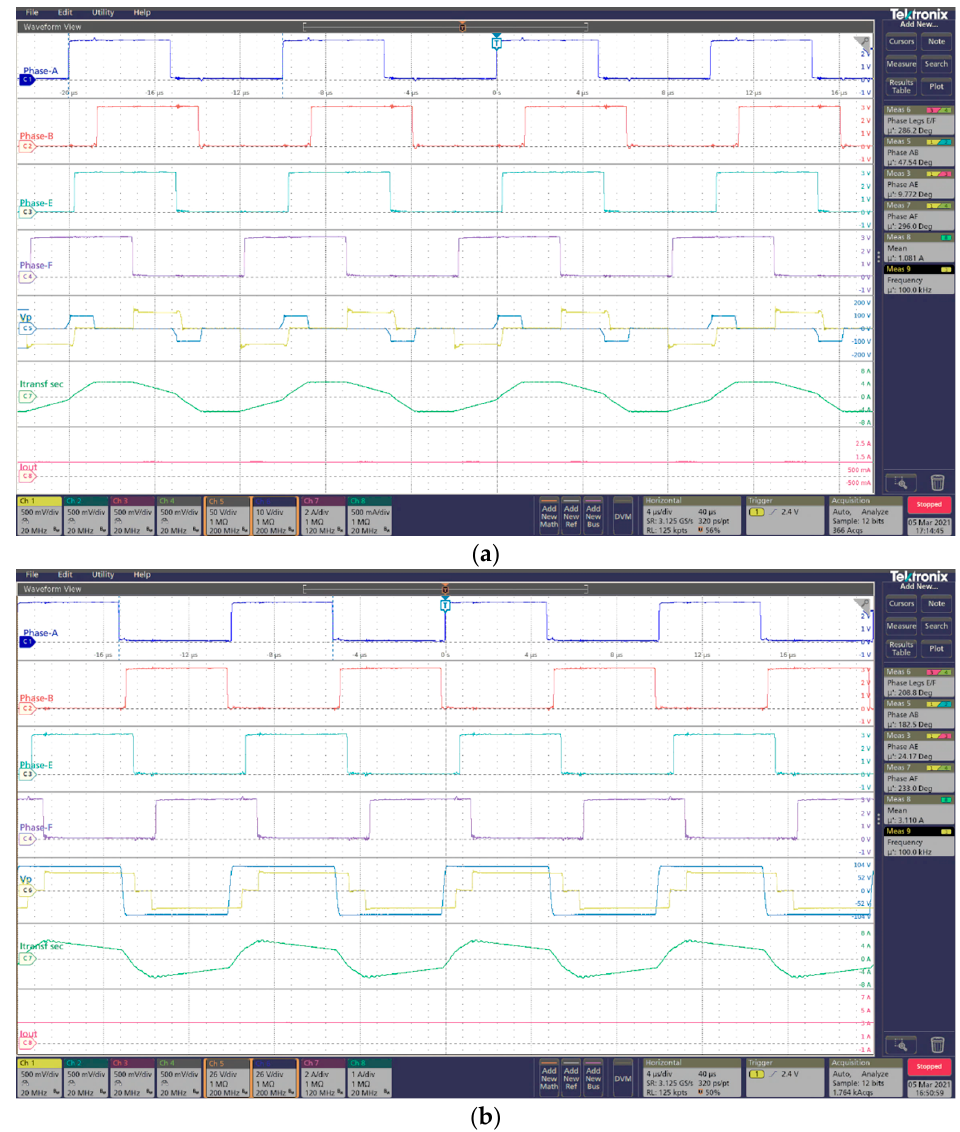
Figure 19. Gate control signals, transformer’s primary and secondary voltage, inductor current and output current average of the experimental model at 100 kHz (optimized control): ( a ) Case 1; ( b ) Case 5.